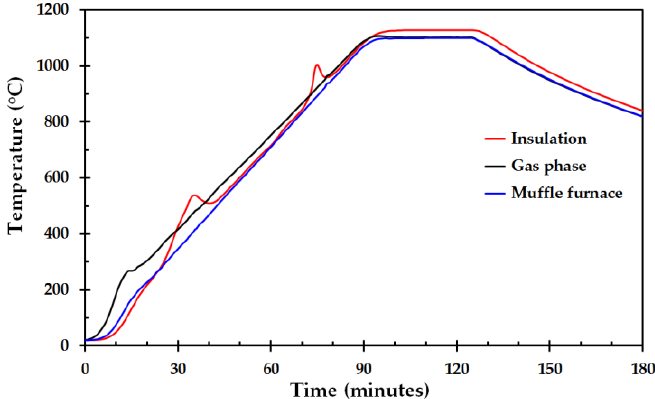
Figure 11. Temperatures recorded in the center of the 50 mm thermal insulation cubes, the gas phase and values displayed at the Muffle furnace (heating rate 15 K/min and 30 min holding time at 1100 °C).